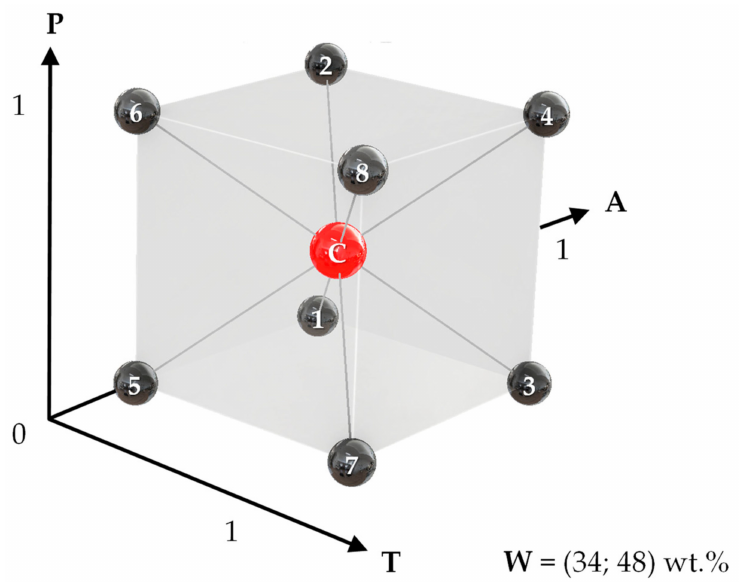
Figure 1. Graphical representation of the DoE. Table 1. Full factorial DoE including all